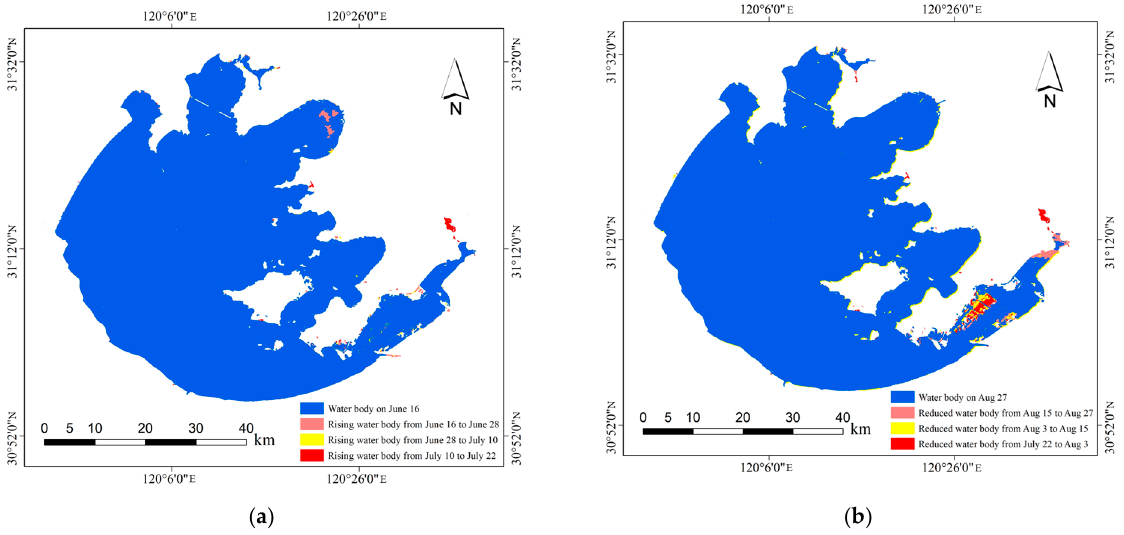
Figure 14. The spatial distribution maps of the water body in Taihu Lake. ( a ) The rising water stage, ( b ) the reduced water stage.